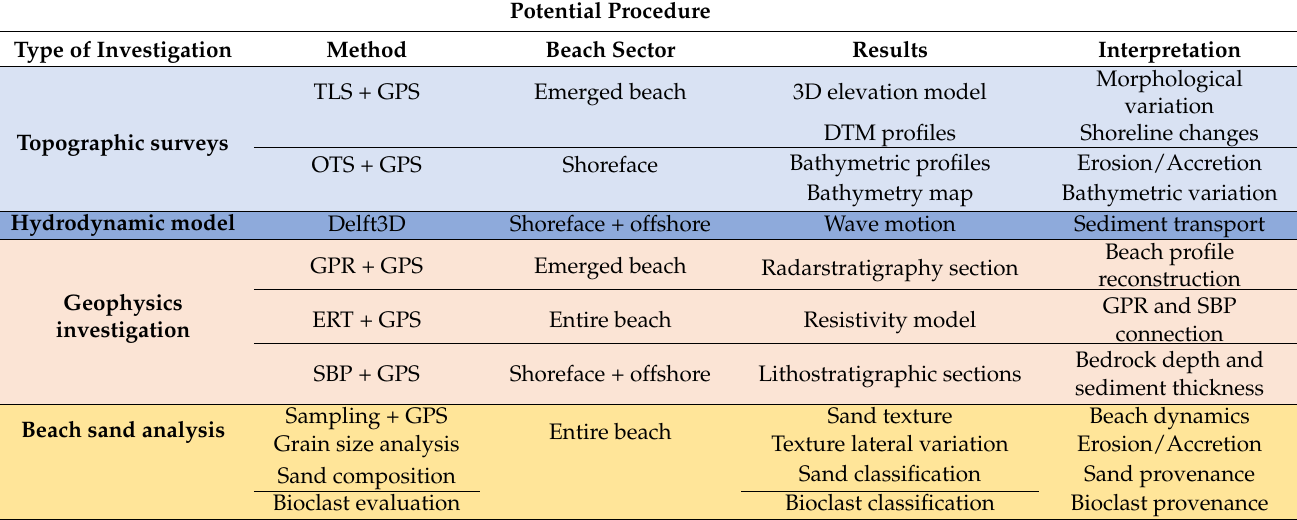
Table 2. Methodological proposal for monitoring sandy beaches. Each color represents the method- ological steps for beach